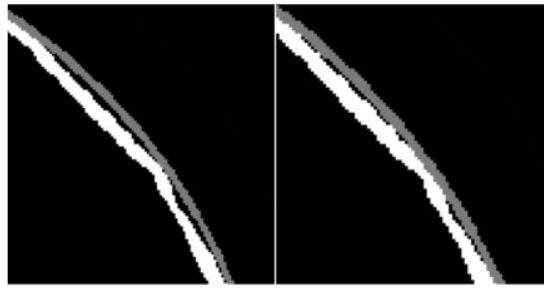
Figure 13. Detail comparison.